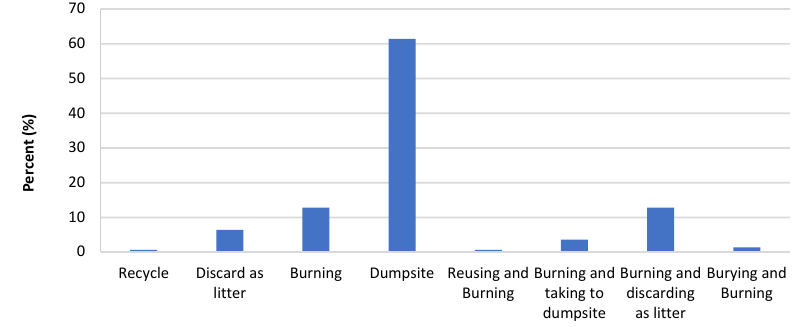
Fig. 4: Plastic waste disposal methods among households in Watamu